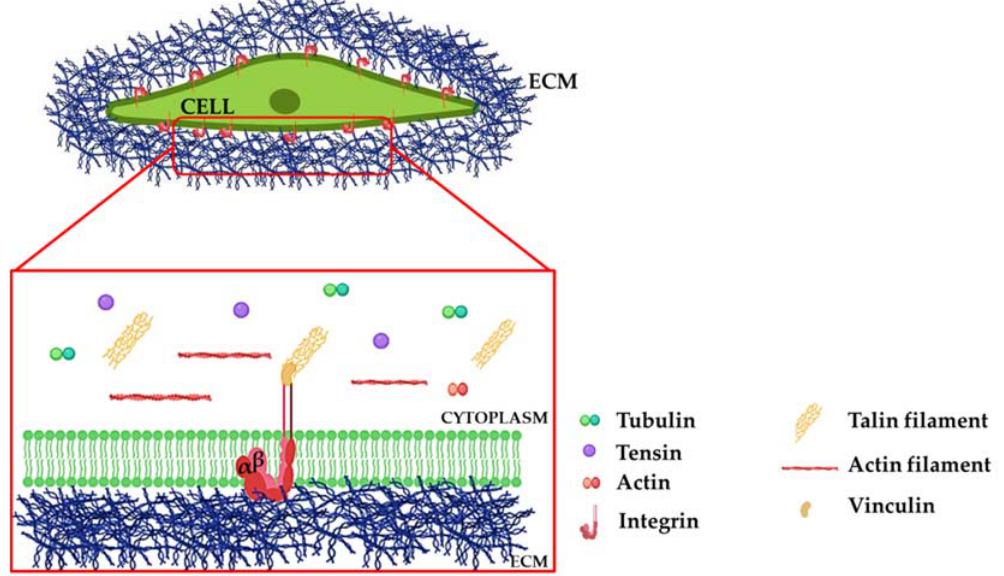
Figure 1. Force transmission through integrins. Schematic representation of a mesenchymal cell expressing integrins and ECM molecules. Integrins transduce messages from the extracellular matrix (ECM) to the actin cytoskeleton by providing a link across the plasma membrane. Any force applied to the ECM leads to ECM molecule rearrangement and is transmitted as a mechanical signal to ligand-bound integrins. The zoom represents the positioning of integrins with respect to ECM components. Integrins do not directly communicate with the cytoskeleton. However, they are composed of a cytoplasmic domain called the tail, connected to actin-binding adaptor proteins such as talin, tensin, or actin, which transmit forces from the integrins to the cytoskeleton.